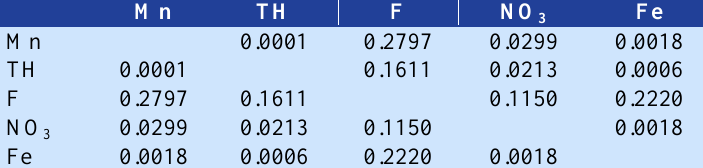
Figure 15. The average concentration of Total Hardness by season 2008-2013 Table 3. Compare of P Value between parameters